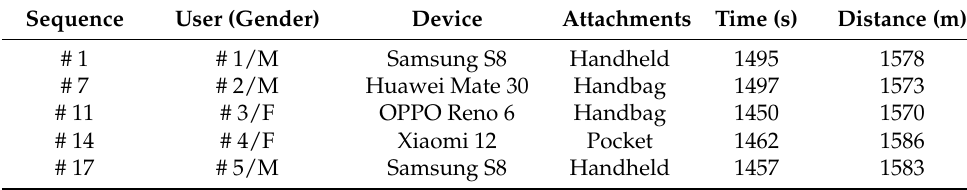
Table 2. Details of the test sequences in the